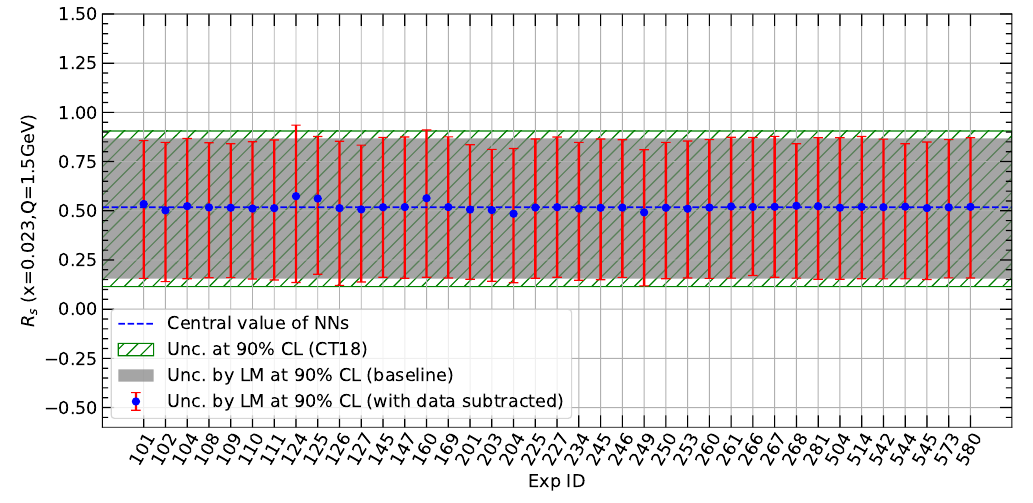
Figure 11 . The results of LM scans on the R s ( x = 0 . 023 , Q = 1 . 5 GeV) with data subtracted. The horizontal axis represents the experimental data set removed from the LM scans. The blue mark and the red error bar respectively indicate the central value and uncertainties at 90% CL determined with the LM method with the rest of the data sets. The green hatched area and the gray band represent the uncertainties at 90% CL determined with the Hessian method and the LM method with the full data set